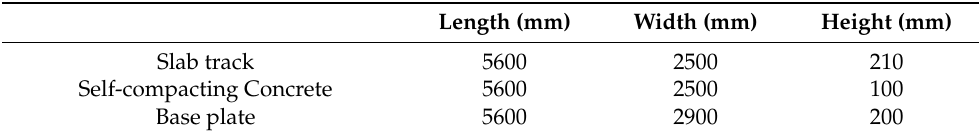
Table 1. Dimensional parameters of CRTS III slab track.